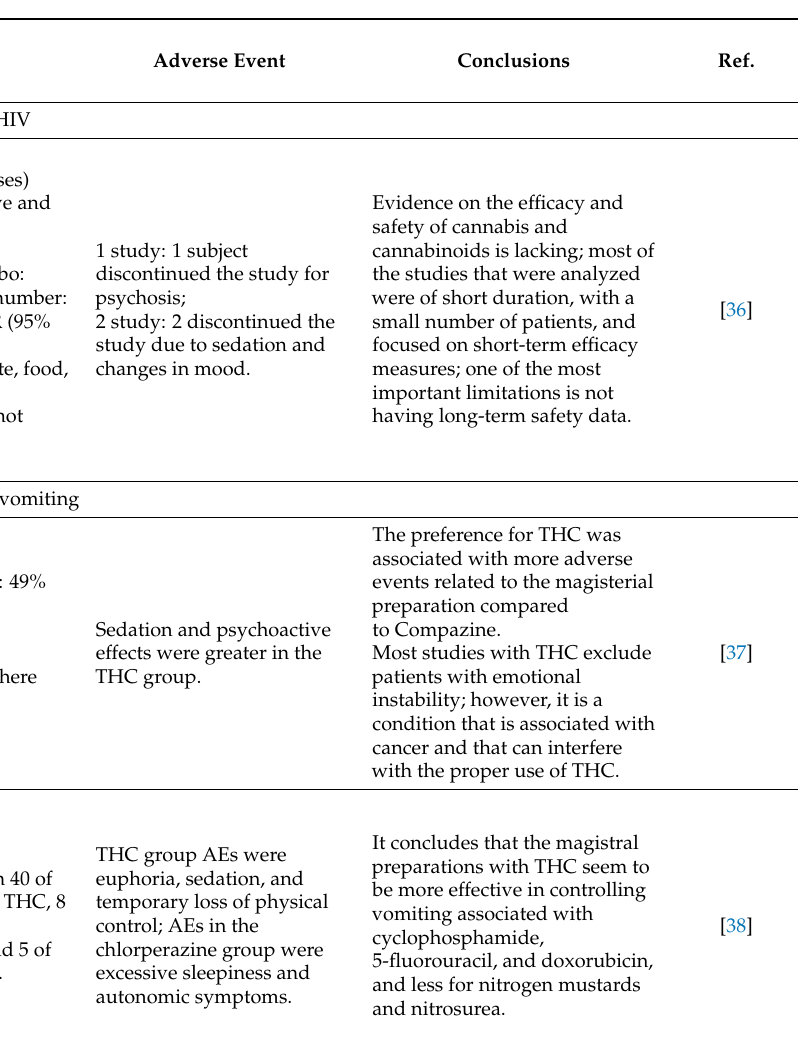
Table 3. Description of selected